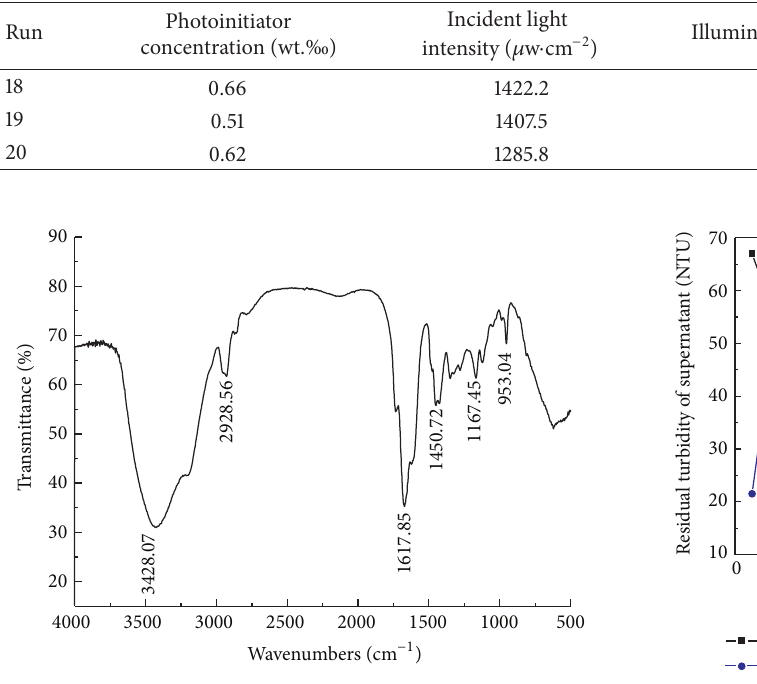
Figure 2: FTIR spectrum of P(AM-DMDAAC-BA).